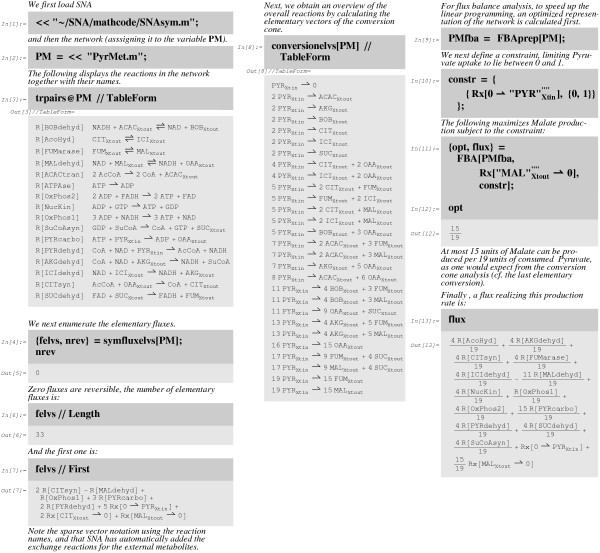
A Mathematica session using SNA to analyse a model of the Pyruvate metabolism in rat liver mitochondria. The model is adapted from [7] where the full metabolite names are given, as well as the explanation for the unusual conversion PYRXtin ⇀ 0.